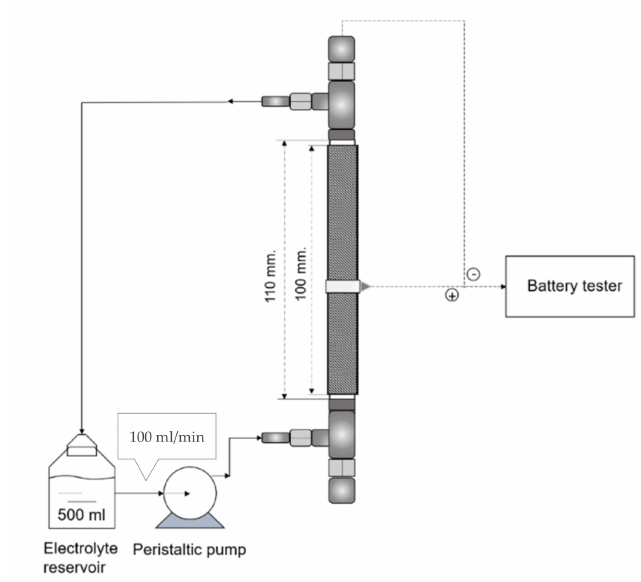
Figure 7. Flow diagram of the Zn–air flow